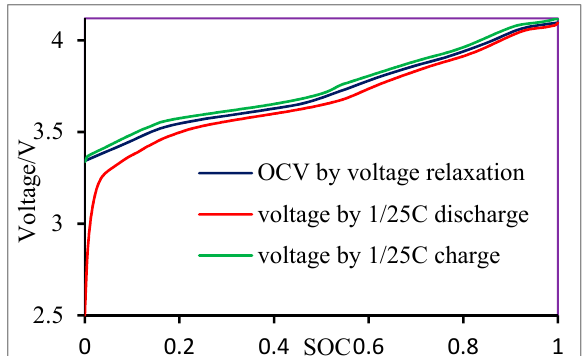
Figure 2. OCV by voltage relaxation and terminal voltage by 1/25 C charge and discharge.